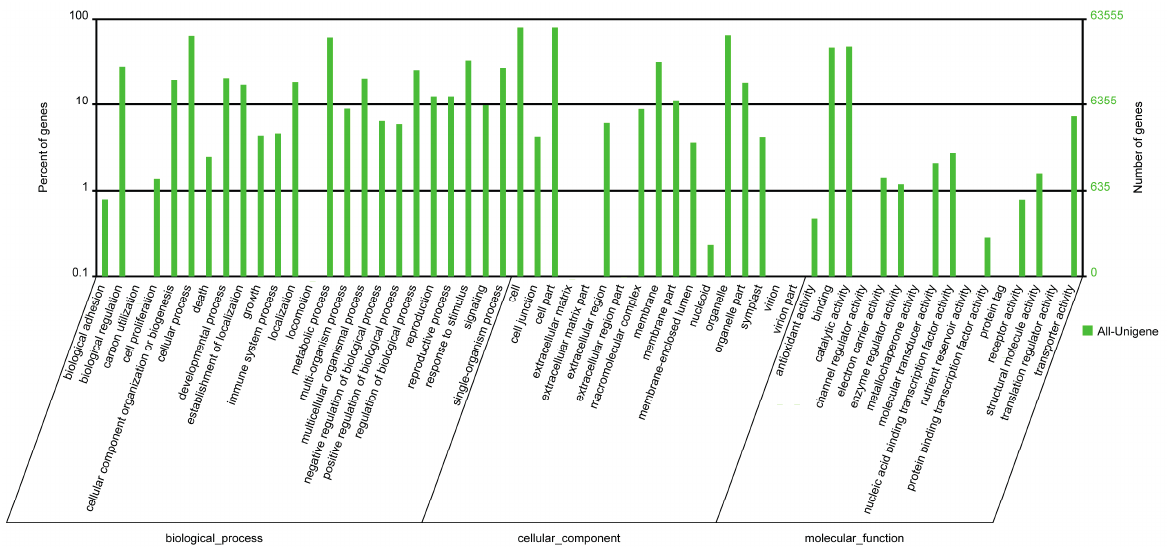
Figure 5. GO (Gene Ontology) classification of the P. fortunei all unigenes. 63,555 unigenes (55.2% of total) were annotated and categorized into 57 function